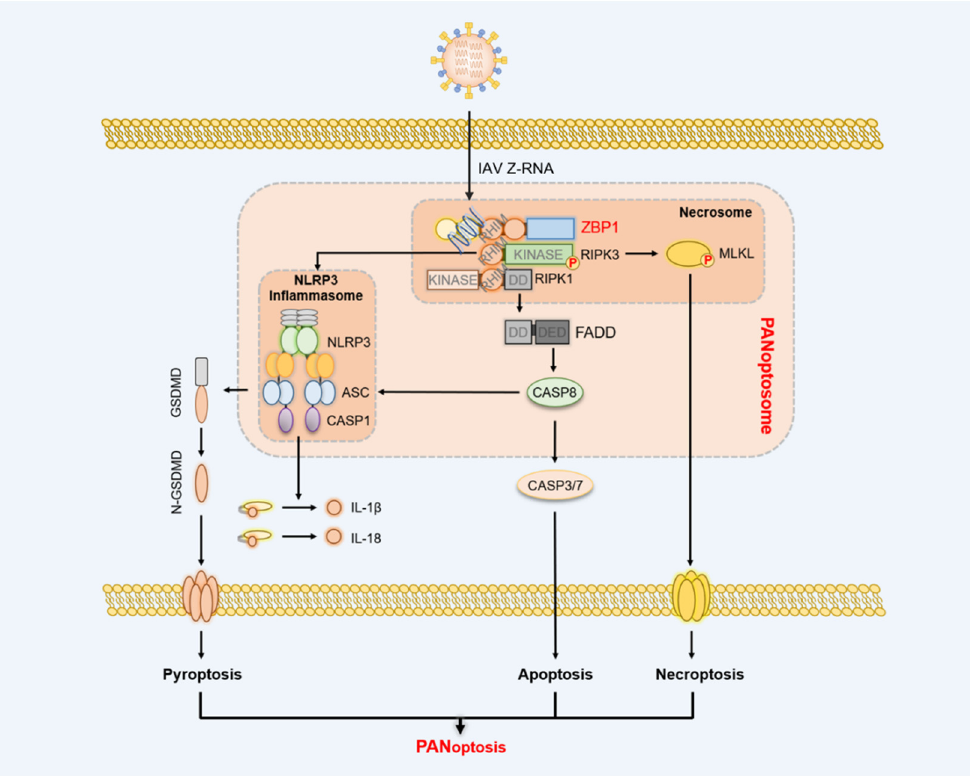
Figure 2. The pattern of ZBP1-initiated PANoptosome assembly. The sensing of ZBP1 Z α for activated ligands allows ZBP1 interaction with RIPK1 and RIPK3 via RHIM domains and forms the core scaffolds of PANoptosome. RIPK3 induces the phosphorylation and membrane translocation of MLKL, which is the hallmark of necroptotic signaling. In addition, the homotypic interaction between RIPK1, FADD, and CASP8 liberates the cleaving activity of CASP8 and CASP3/7 that causes apoptosis. ZBP1-mediated apoptosis and necroptosis signaling promote the assembly and activation of NLRP3 inflammasome. Activated NLRP3 inflammasome matures GSDMD, IL-1 β , and IL-18, named pyroptosis.